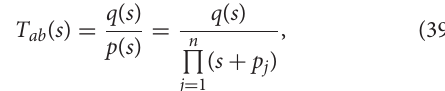
TABLE 2 | Estimated (dimensionless) synaptic gains for normal adults in the alert, eyes-open state (Robinson et al., 2004).